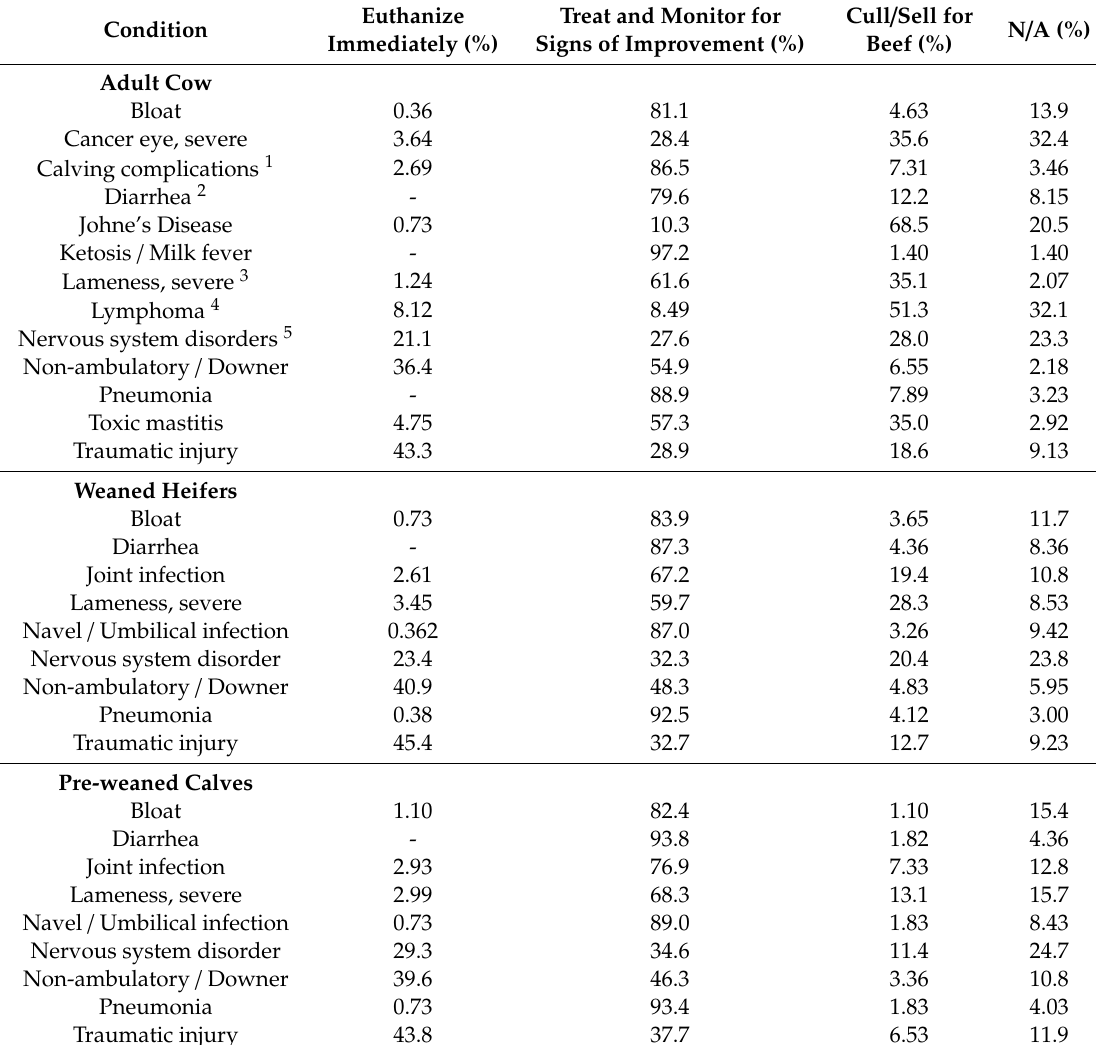
Table 2. Response percentages of surveyed dairy cattle producers ( n = 270) when asked to select how they would manage the following